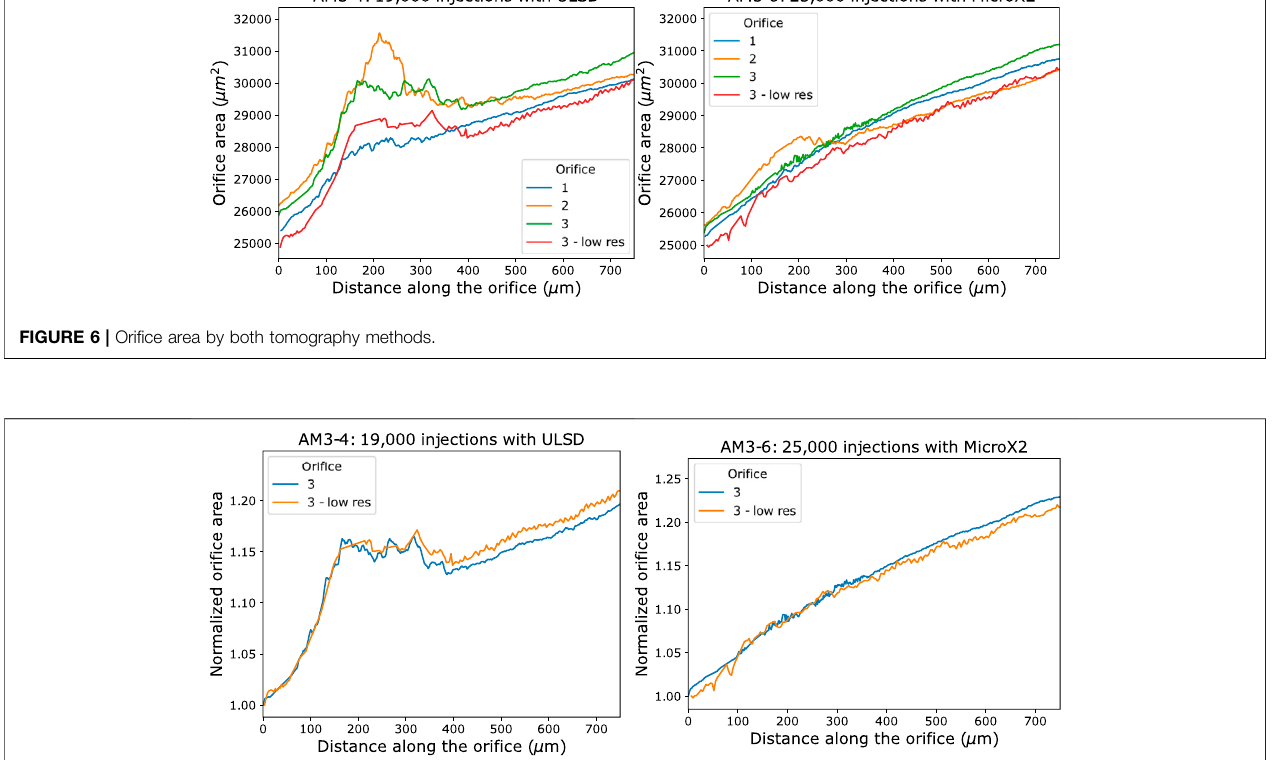
FIGURE 7 | A comparison of ori fi ce 3 areas between the tomography methods. The area has been normalized by the entrance area.